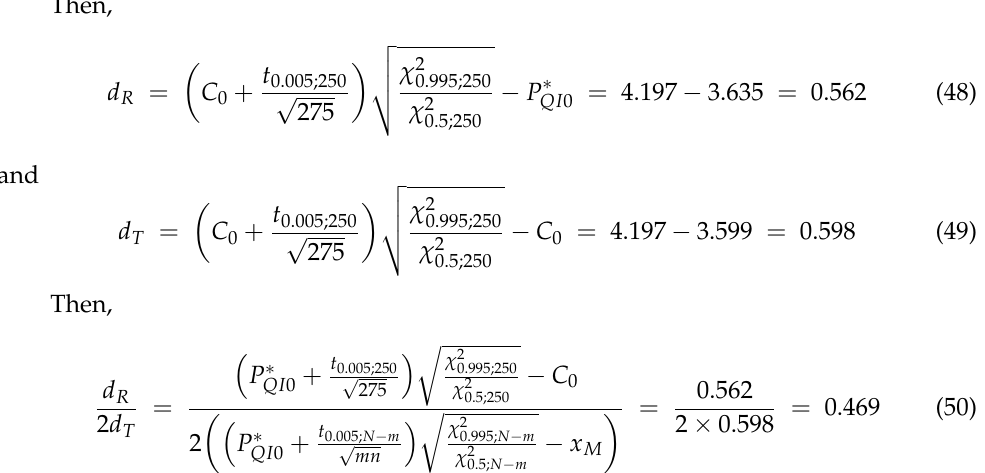
Figure 3. Diagram of η 0 ( x ) with ∆ (cid:101) x = ( 3.635, 4.237 ) and η ( x ) with ∆ (cid:101) C 0 = ( 3.599, 4.197 )